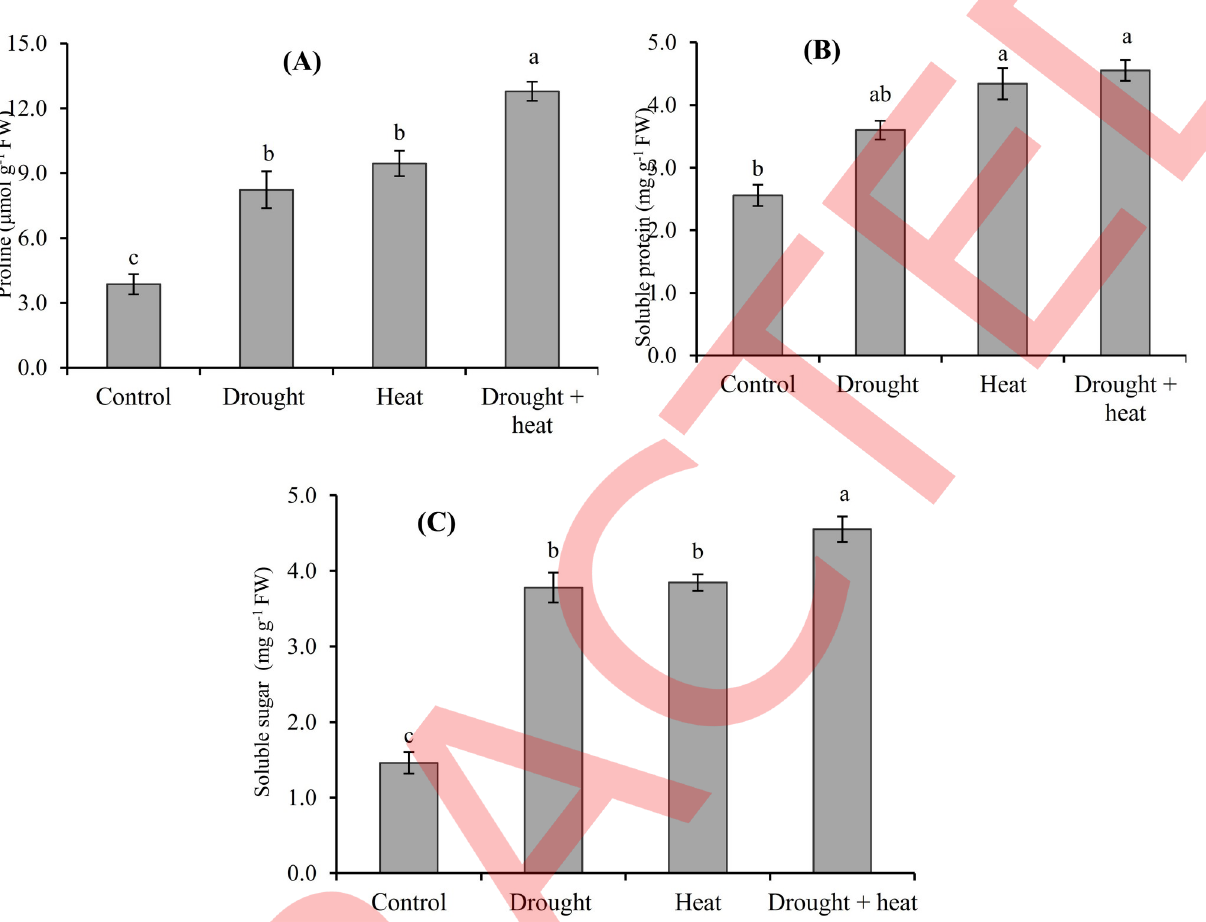
Fig 4. Effects of different drought and heat treatments on proline (A), soluble protein (B) and soluble sugar (C) of wheat. Values show mean ± SE (n = 3). Bars sharing the same letters are statistically at par with each other at significance level of 5% ( P � 0.05).